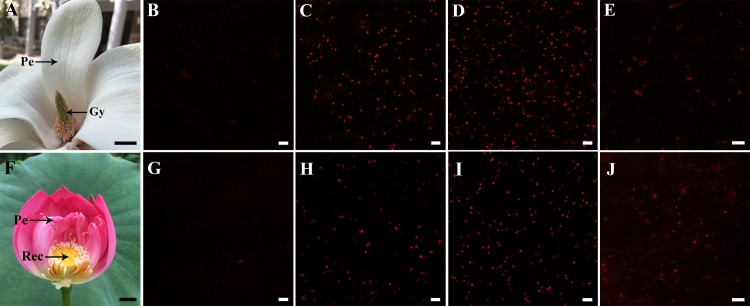
Sampling and detection of isolated mitochondria.Sampling of Magnolia denudata (A) and Nelumbo nucifera (F). Detection of auto-fluorescence of intact chloroplasts in M. denudata (B) and N. nucifera (G). Viability of isolated mitochondria in petal (C) and style (D) of M. denudata, petal (H) and receptacle (I) of N. nucifera using our efficiency method A (crude isolated mitochondria). Viability of mitochondria isolated from style in M. denudata (E) and from receptacle in N. nucifera (J) using method B (density gradient-purified mitochondria). Pe: petal, Gy: gynoecium, Rec: receptacle. Scale bar: 5 µm.(All photoes were taken by Chulan Zhang).